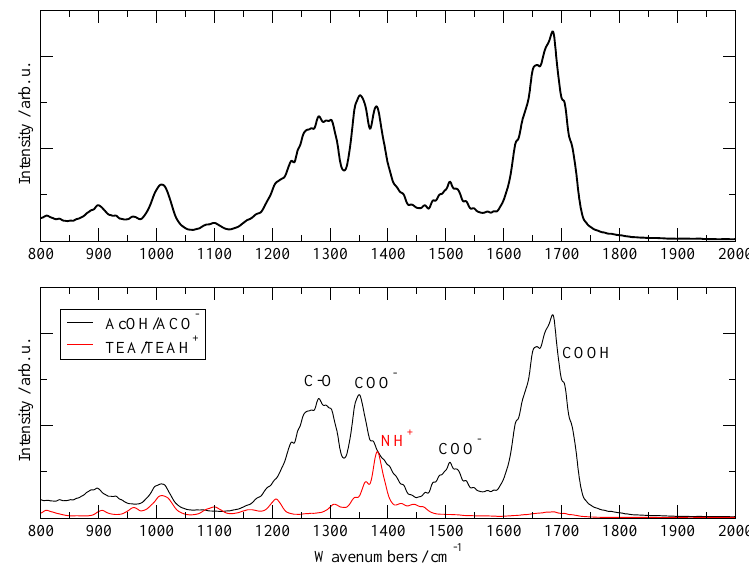
Figure 1. Calculated IR absorption spectra. Top panel: total IR spectra. Bottom panel: contribution from AcOH/AcO – (black) and from TEA/TEAH + (red).